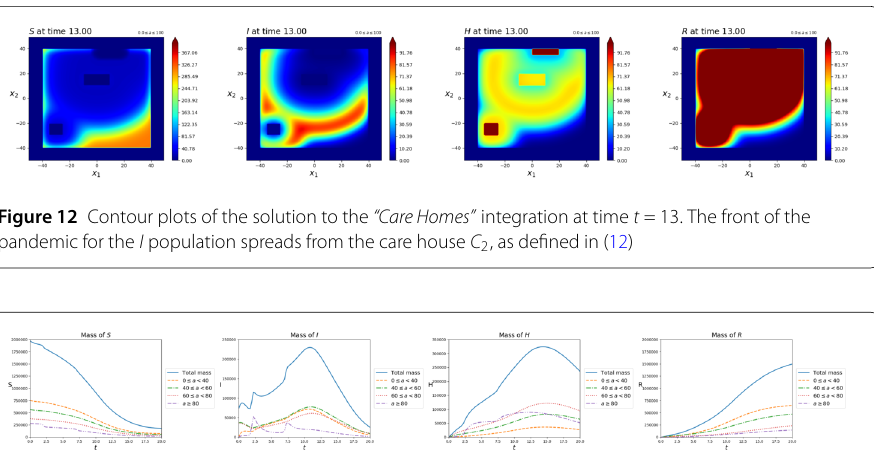
Figure 13 Total amount of individuals of the four populations over all the domain and all age classes, as a function of time, with reference to the “CareHomes” integration. Remarkably, the initial tendency of the I population is towards a reduction but, as soon as the virus reaches C 1 , at about t = 2, this tendency is reverted and the pandemic accelerates